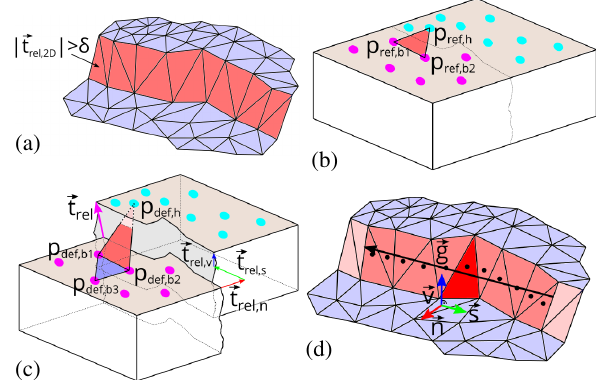
Figure 11. (a) Thresholding applied to || ⃗t rel, 2 D || to detect deformed triangles in red whereas undeformed triangles are blue; (b) block before cracking in the reference state; (c) broken block with relative shift of the right half such that the red crack triangle is deformed, the neighboring base triangle is shown in blue; (d) crack direction ⃗g determination by line fit through neighboring deformed triangles (red) and coordinate system of the crack opening vector derived from ⃗g . Based on (Liebold et al., 2020b).